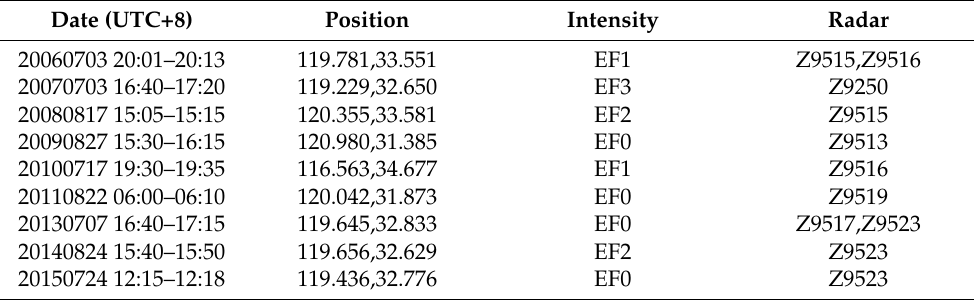
Figure 1. The generation flow of tornado dataset. (Firstly, divide the radar into many blocks; then, calculate the tornado-related features in each block; finally, label the samples according to tornado time and position information, and obtain the tornado dataset). Table 2. Historical tornado events from 2006–2015 were used to build the tornado dataset and train the TDA-RF model. The position represents latitude and longitude,